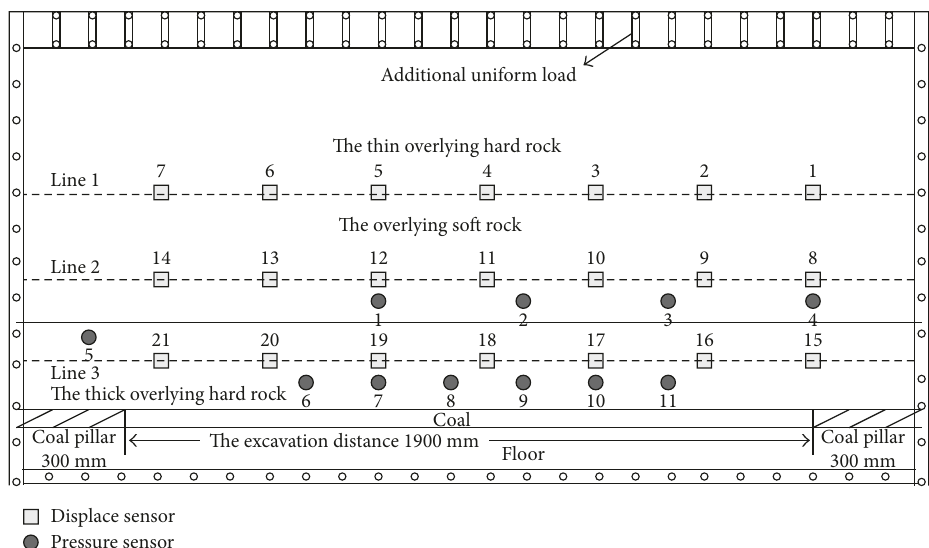
Figure 2: Arrangement of displace sensors and pressure sensors.